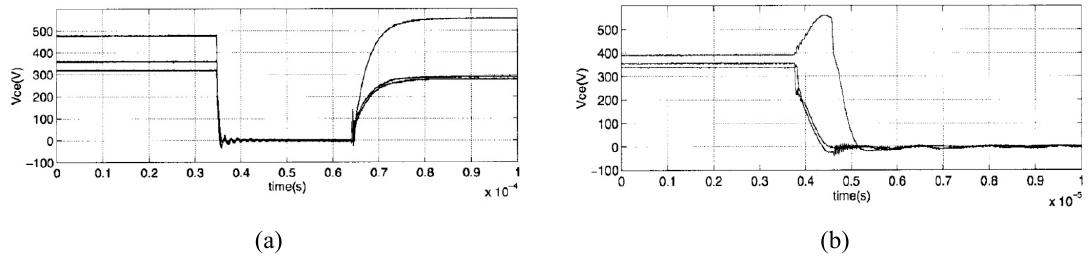
Figure 2. Typical series connection voltage sharing issues when no-balancing method is applied: ( a ) Static voltage unbalance occurring before 35 µ s (turn-on) and after 65 µ s (turn-o ff ) instants; ( b ) voltage zoom on the turn-on transient showing a poor dynamic voltage sharing [4].